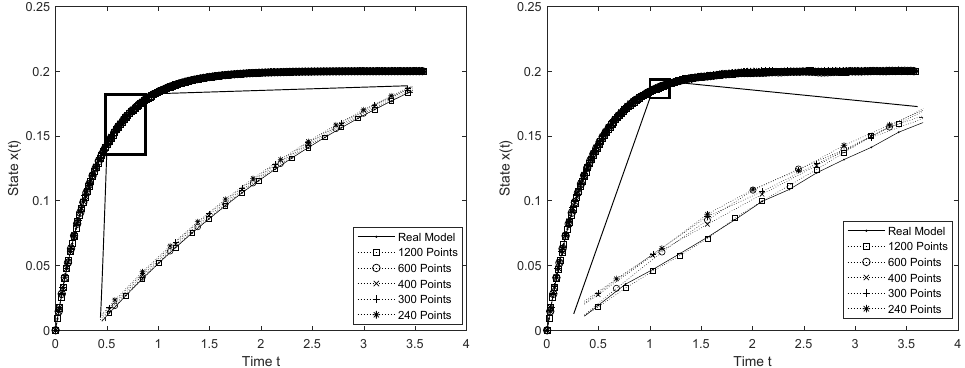
Figure 1. Asymptotic behavior of x θ LSEm , f θ LSEm ( t ) with σ = 0.0001 ( left ) and σ = 0.0007 ( right ).